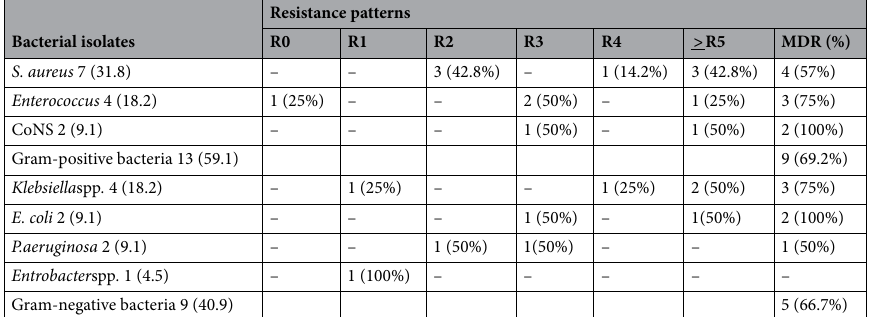
Table 4. Multiple antibiotic resistance patterns of bacterial isolates from blood culture of patients at AMGH, southern Ethiopia 2020. n: number of isolates, R0: No resistance at all, R1: resistant to one antibiotic, R2: resistant to two antibiotics, R3: resistant to three antibiotics, R4: resistant to four antibiotics, R5: resistant to five or more